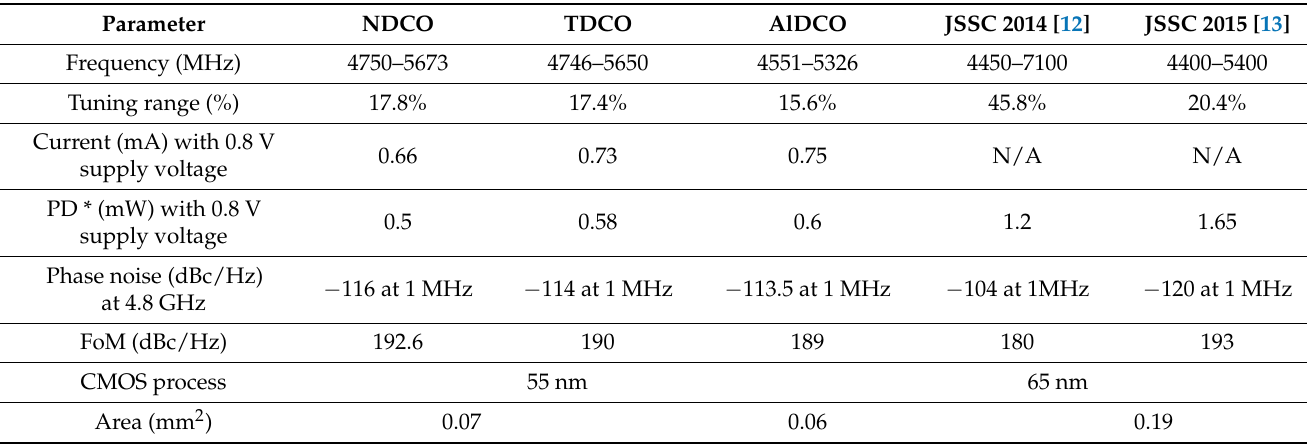
Phase noise (dBc/Hz)